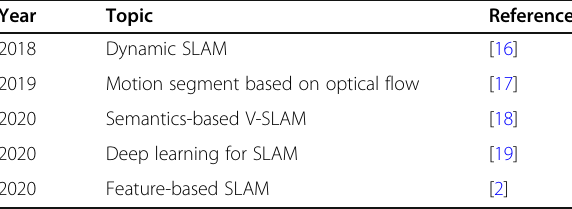
Table 1 Recent surveys related to dynamic